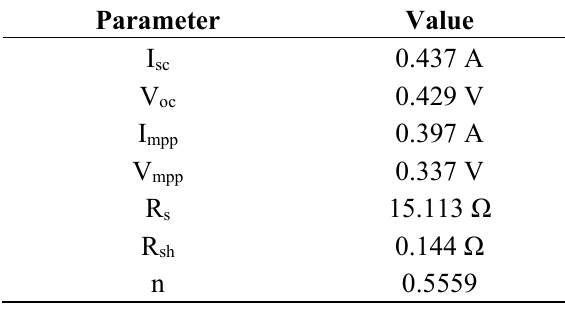
Table 2. PV cell electric characteristics.